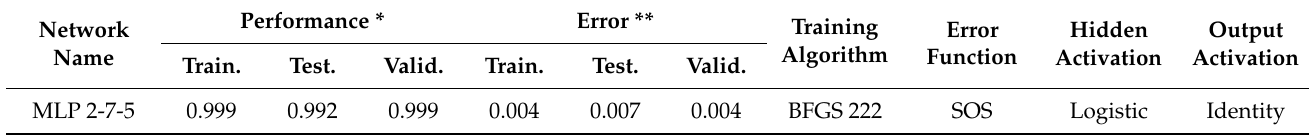
Table 4. Artificial neural network model summary (performance and